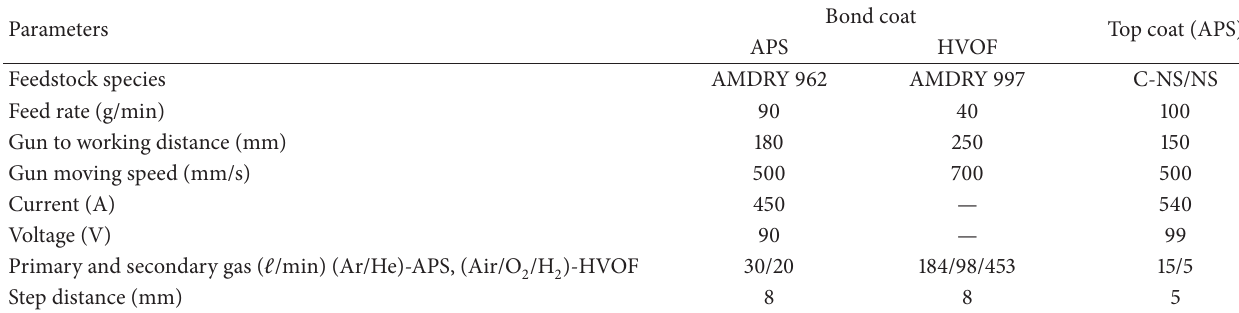
Figure 1: Cross-sectional microstructures of TBCs with and without plasma pretreatment on bond coat: (a) 204 C-NS with HVOF bond coat without plasma pretreatment (TBC-A), (b) 204 C-NS with HVOF bond coat with plasma pretreatment (TBC-B), (c) 204 C-NS with APS bond coat without plasma pretreatment (TBC-C), (d) 204NS with HVOF bond coat without plasma pretreatment (TBC-D), (e) 204 NS with HVOF bond coat with plasma pretreatment (TBC-E), and (f) 204 NS with APS bond coat without plasma pretreatment (TBC-F). Table 1: Coating parameters for preparing the bond and top